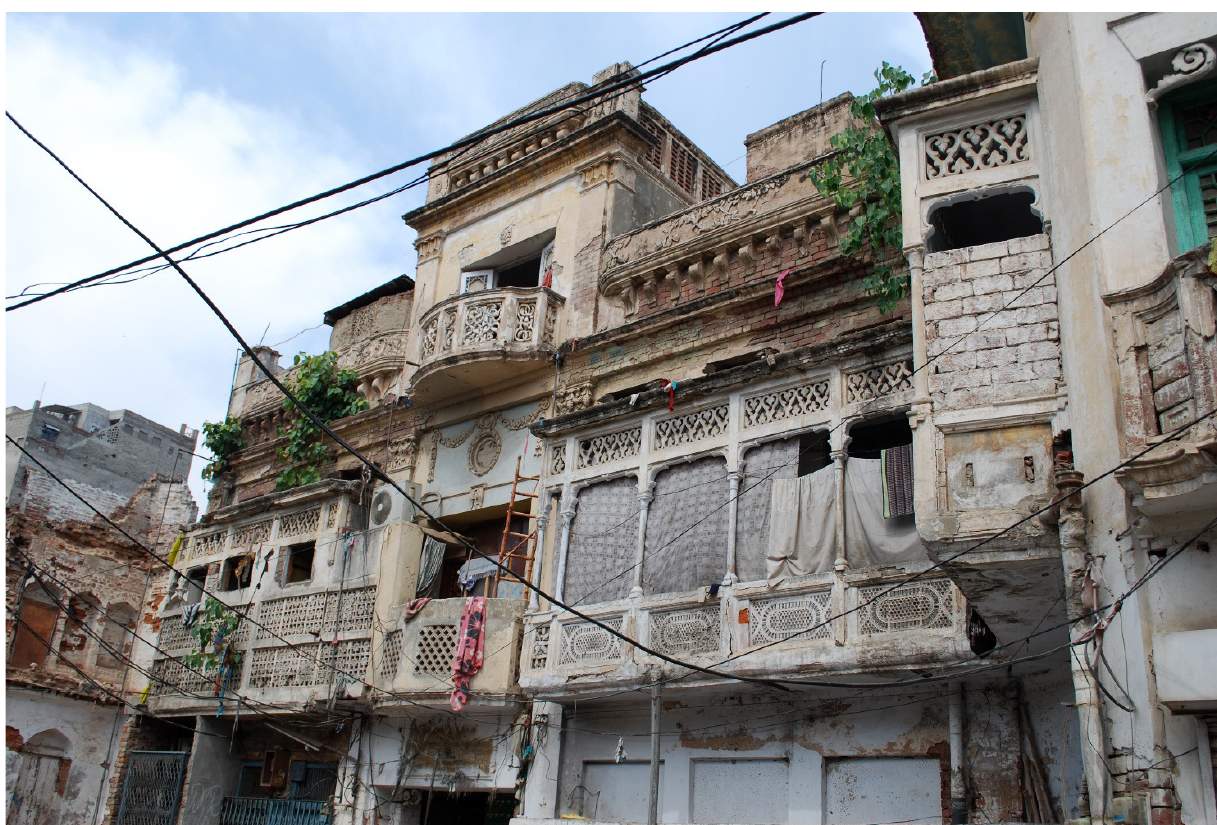
Figure 1. House in the Walled City with decorative designs on its facade. Photo by Katja Mielke (2012). doors and jharokas (upper story windows projecting